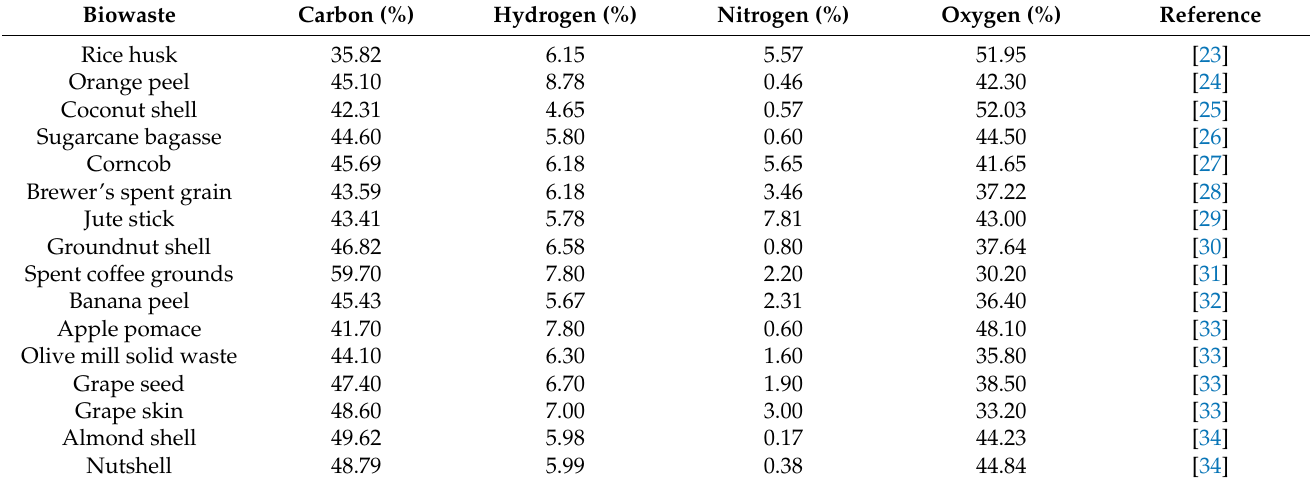
Table 1. Ultimate analysis reports of some biowastes.